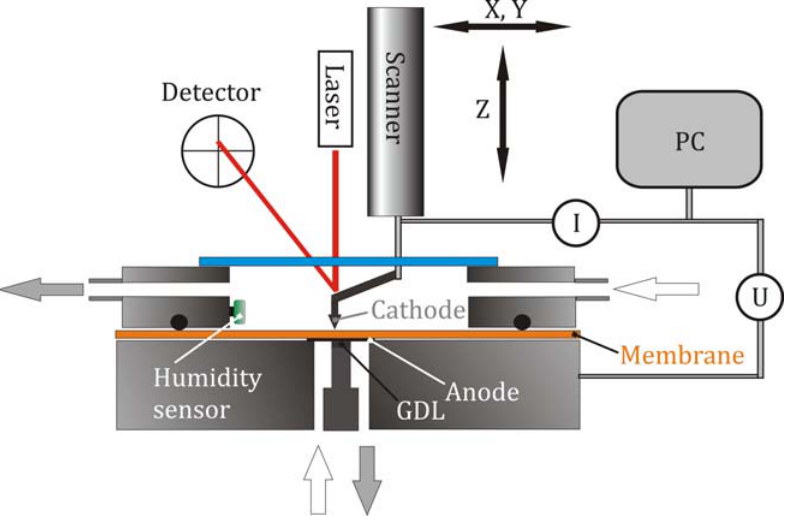
Figure 1. Experimental set-up: A membrane separates two environmental chambers with gas atmospheres which can be controlled independently but were identical for the present work. The upper side is sealed off by a perfluorosilicone cap in which the cantilever holder is embedded. The cantilever deflection is measured through a small glass window. An external PC runs the chronoamperometric